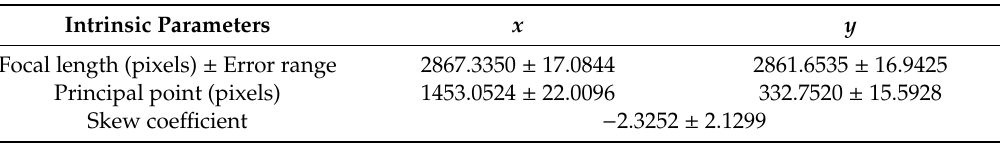
Table 2. Intrinsic parameter after